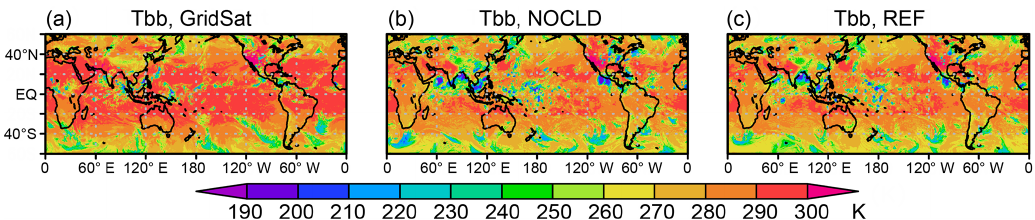
Figure 7. TOA brightness temperature near 11µm at 00:00UTC 6 June 2004 from the GridSat product (a) and the NOCLD (b) and REF (c) runs by NICAM16-9S. The display style follows Fig. 1 of Roh et al. (2017). The grid interval in (b) and (c) is 0.14 ◦ .